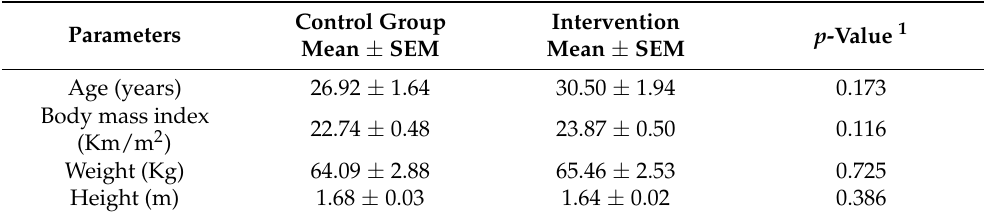
Table 1. Baseline characteristics of the study participants (n = 12, each group).